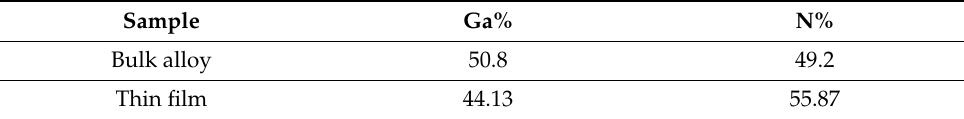
Table 1. The EDX analysis of GaN bulk alloy and thin film.